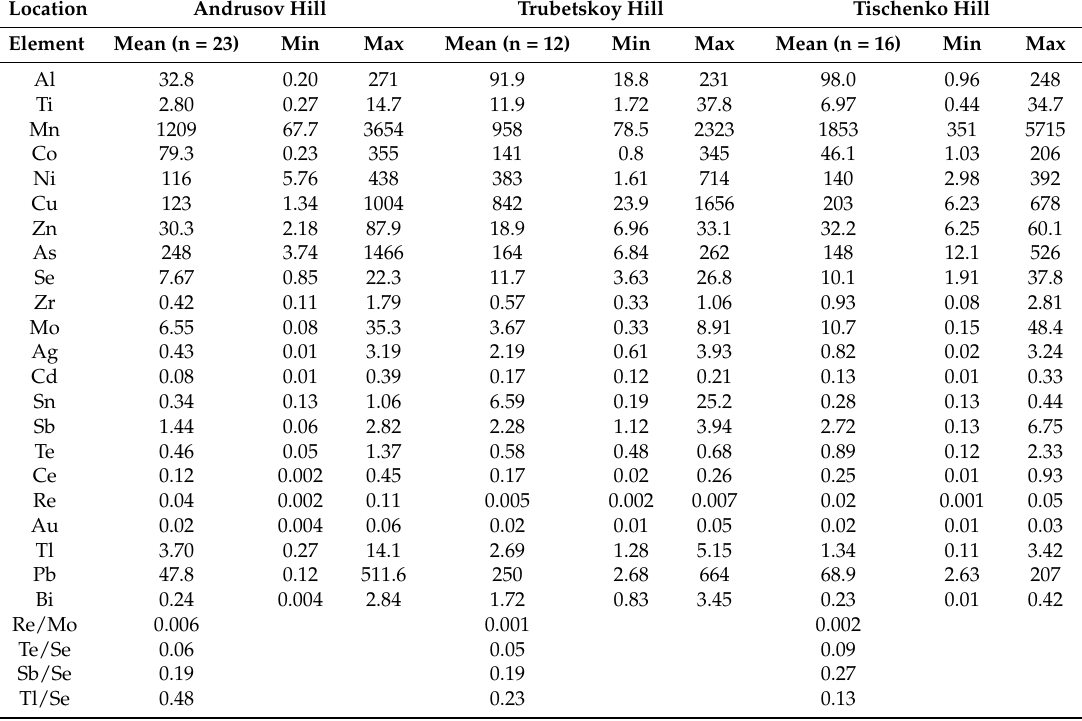
Table 7. Trace element composition of pyrite framboids from mud masses, Bulganak MV area, Kerch-Taman MV province. LA-ICPMS data,